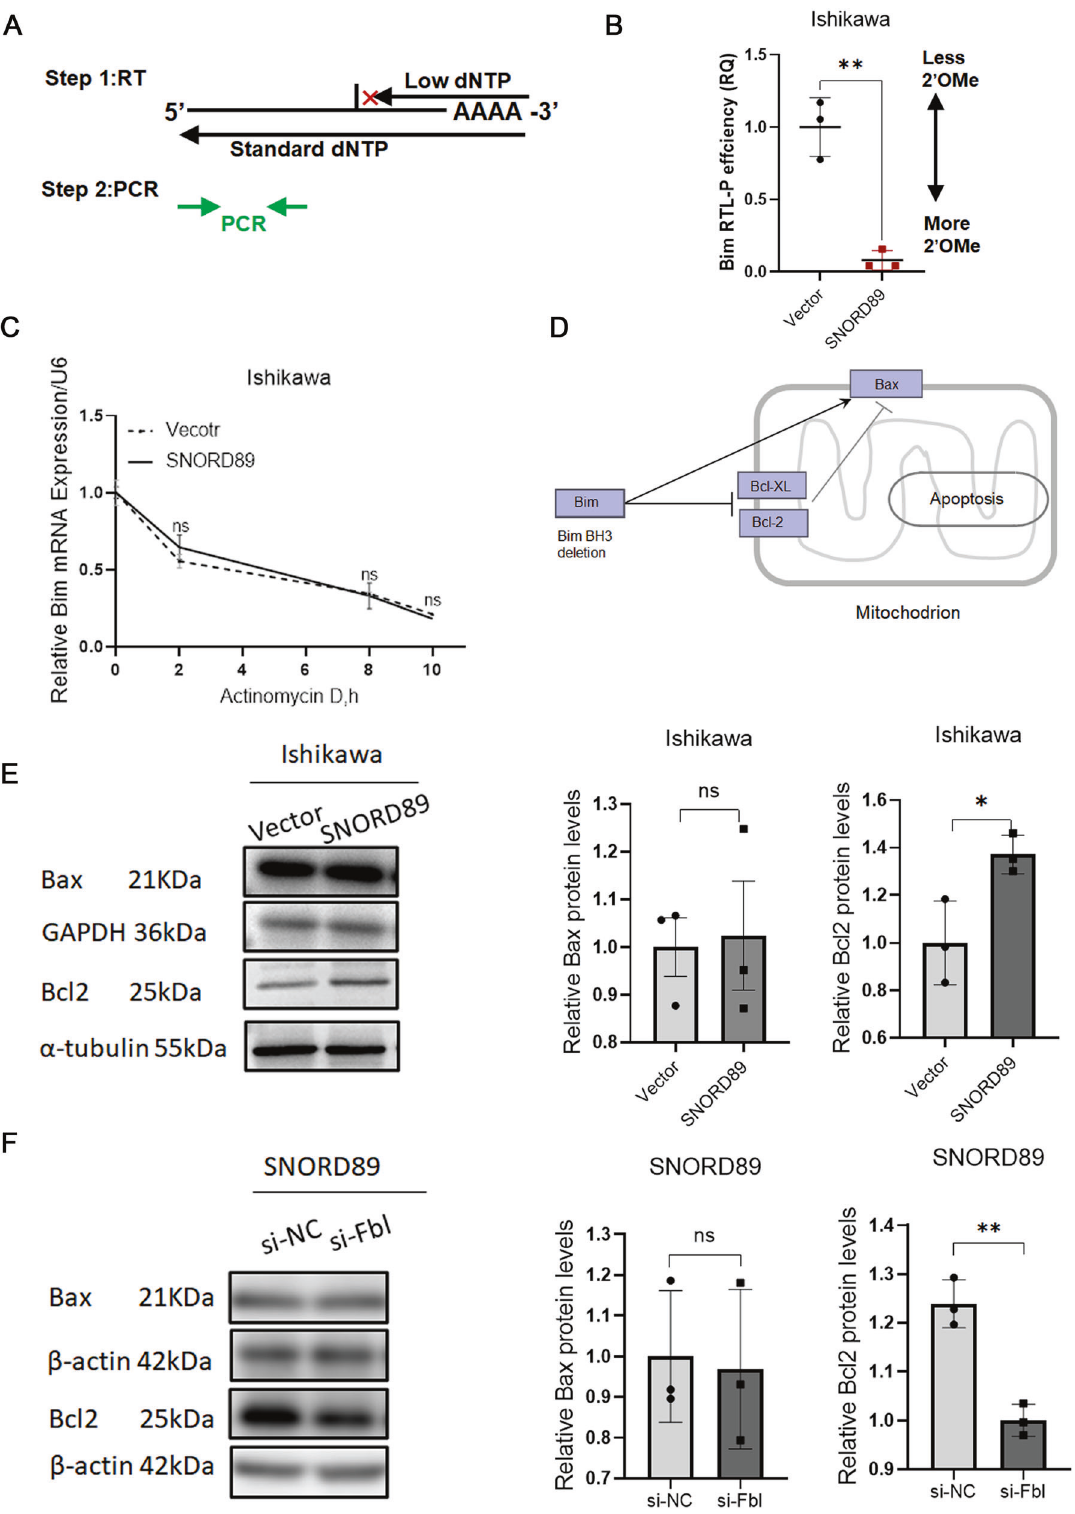
Fig. 5 Changes of Bim mRNA and downstream pathways. A Illustration of the RTL-P method. The amount of qPCR product from the low dNTP reactions of two different samples can be compared to establish the relative “ RTL-P ef fi ciency (RQ) ” . RQ relative quantity. See Methods for detail. B Under the low concentration of dNTPs, the Bim product was signi fi cantly reduced after overexpression of SNORD89 and showed higher RTL-P ef fi ciency. C Bim mRNA stability had no signi fi cant change compared with the vector group ( n = 3). D Bim /Bcl-2/ Bax was an important signaling pathway that mediated apoptosis. E Overexpression of SNORD89 increased Bcl2 protein level and Bcl2 / Bax ratio ( n = 3). F In Ishikawa cells overexpressing SNORD89 , silencing Fbl reduced Bcl2 protein and Bcl2 / Bax ratio ( n = 3). Values are presented as the mean ± SD. * p ≤ 0.05; ** p ≤ 0.01; *** p ≤ 0.001.